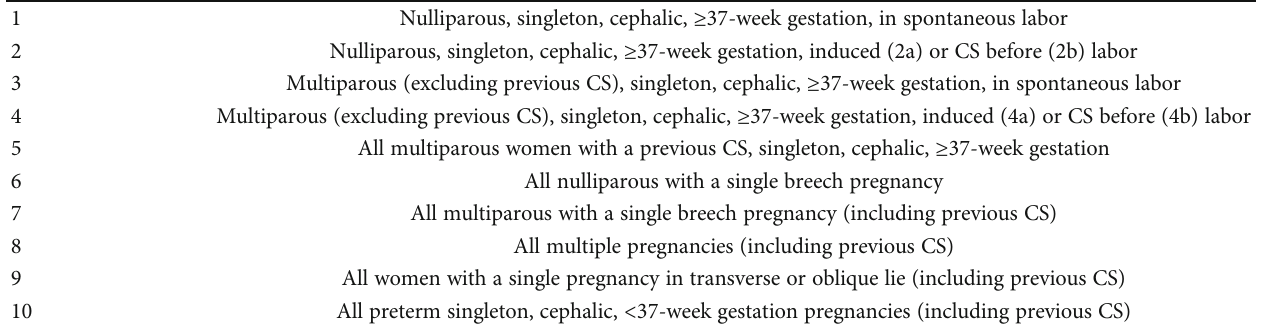
Table 1: The Robson 10-Group Classi fi cation System (TGCS)